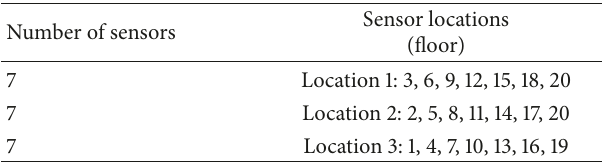
Table 7: The mean value and standard deviation of errors for the estimated wind load with − 10% error in damping — — Table 4: Number of sensors and corresponding locations. Number of sensors